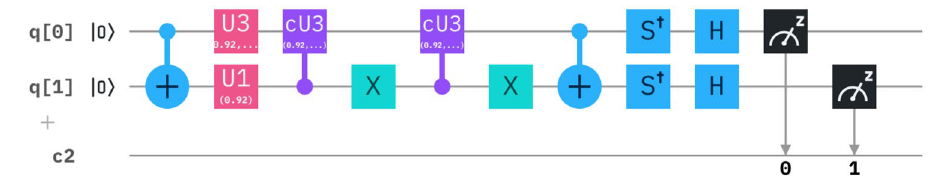
Figure 6. Measurement bases for the calculation of average values of <σ y σ y > for N = 2 in circuit.